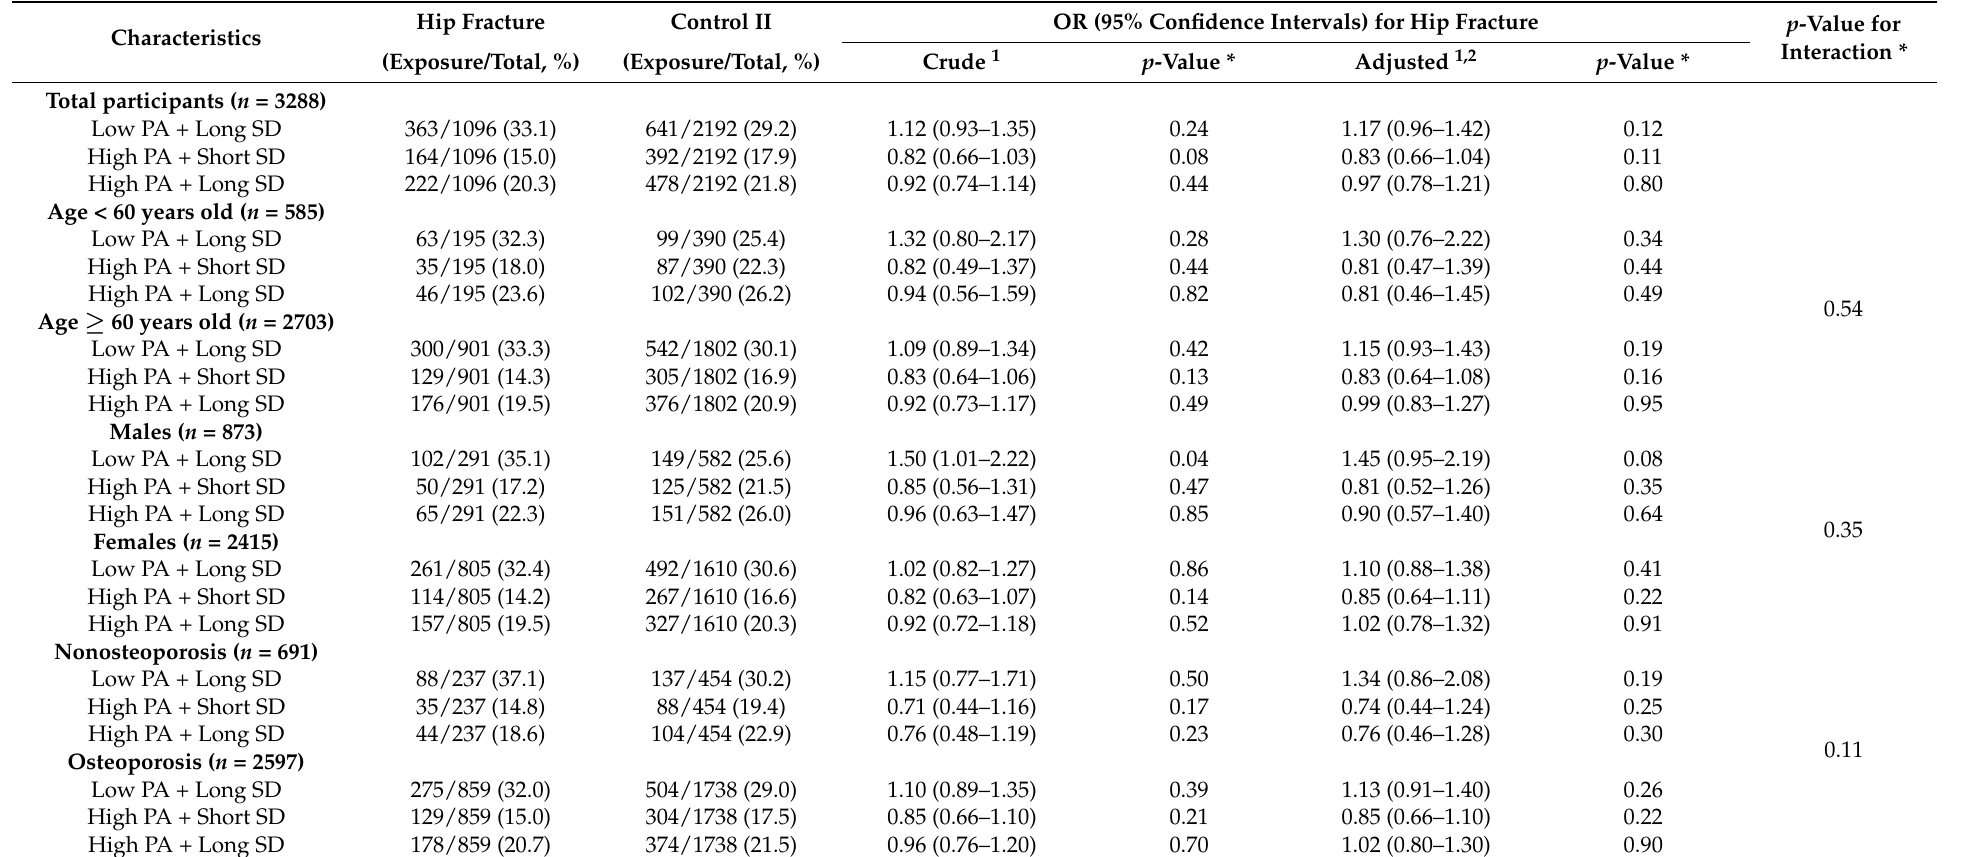
Table 3. Odds ratios (95% confidence intervals) of physical activity and sunshine duration for hip fracture with subgroup analyses according to age, sex, and osteoporosis history (reference: Low PA + Short